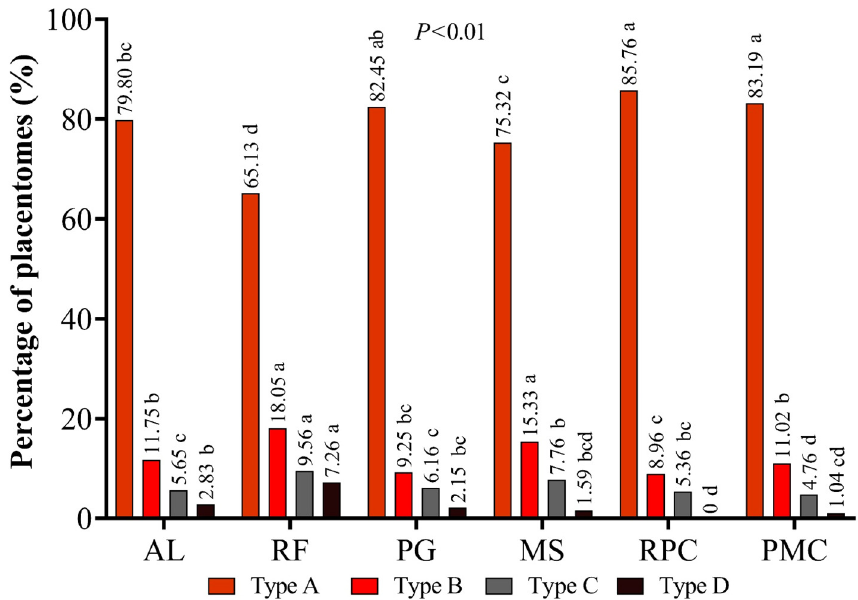
Figure 1. Effect of feed restriction and supplementation with the 3 compounds propylene glycol, monensin sodium, and rumen-protected choline chloride in late pregnancy on the percentage of type A, B, C, and D placentomes. AL = ad libitum feed intake; RF = restricted feeding; PG = restricted feeding plus propylene glycol; MS = restricted feeding plus propylene glycol and monensin sodium; RPC = restricted feeding plus propylene glycol and rumen-protected choline chloride; PMC = restricted feeding plus propylene glycol, monensin sodium, and rumen-protected choline chloride. Values are means with their standard errors being shown by vertical bars. Different letters indicate significant differences among treatments.